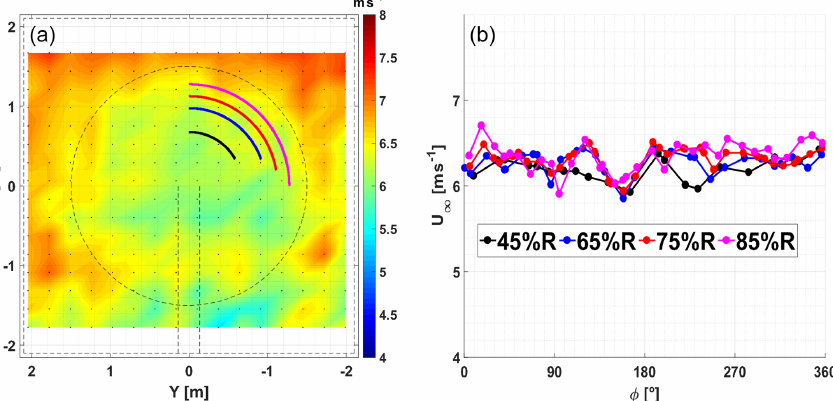
Figure 2. Axial inflow. Dashed lines: tip and tower positions. Colored lines: radial positions at 45% R , 65% R , 75% R and 85% R following the blade rotation (a) . Velocity distributions over radial positions at 45% R , 65% R , 75% R and 85% R (b) .